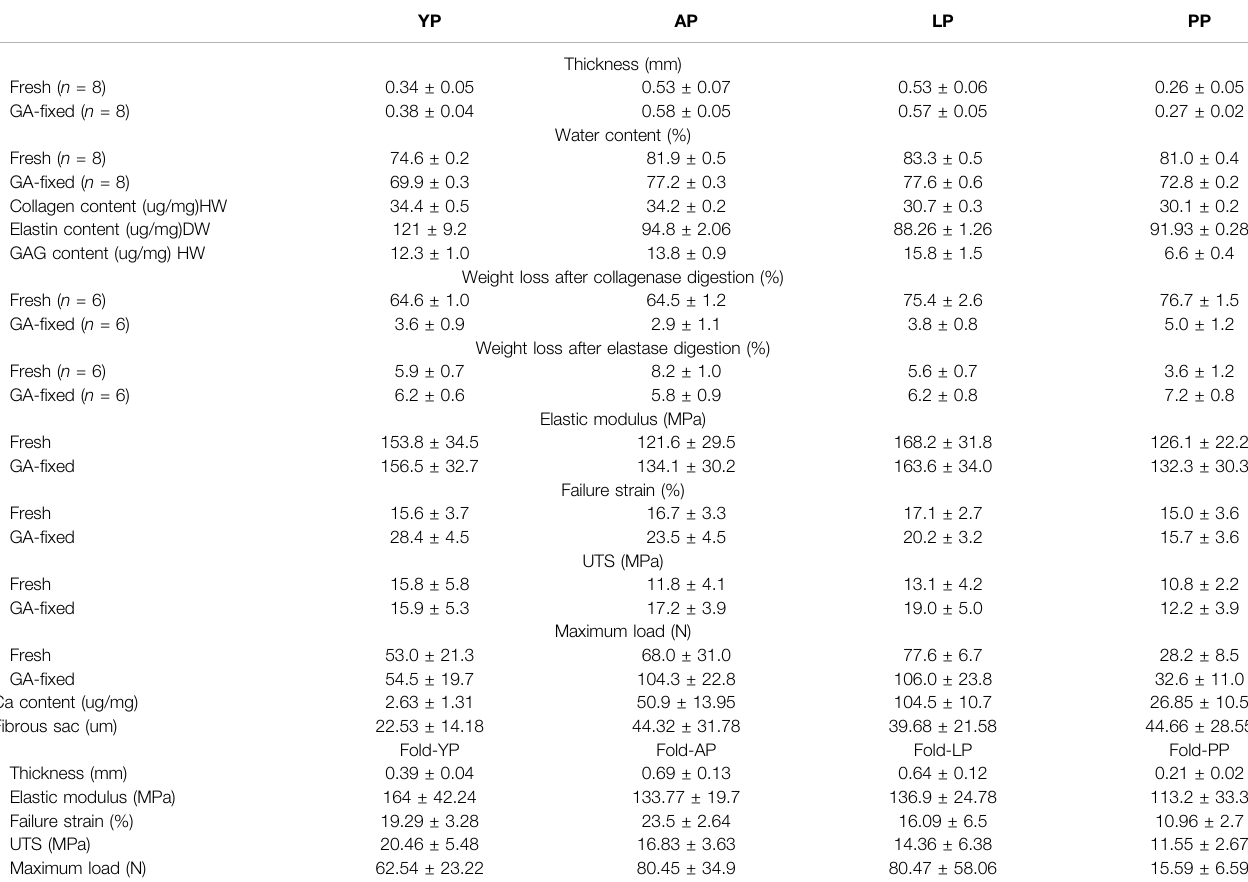
TABLE 1 | Morphology characteristics and mechanical properties for the 4 pericardia